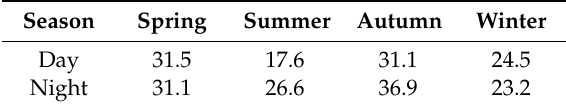
Table 1. Seasonal mean percentages (%) of valid LST data over the YRD from 2010 to 2013. Season Spring Summer Autumn Winter Day 31.5 17.6 31.1 24.5 Night 31.1 26.6 36.9 23.2